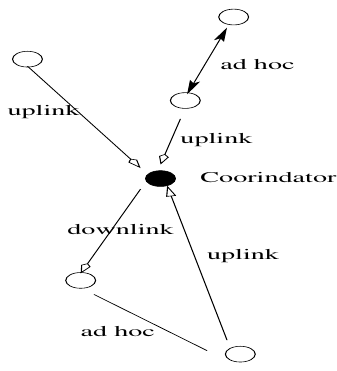
Fig. 1. WPAN with a PAN coordinator and four